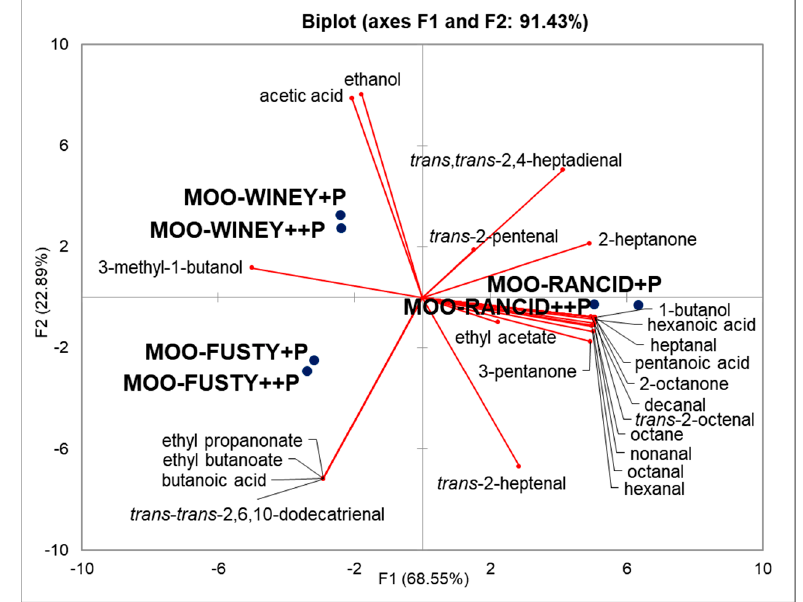
Figure 1. PCA based on SPME-GC/MS analysis of volatile compounds characterising MOO samples with the presence of sensory defects of ‘rancid’, ‘winey–vinegary’ and ‘fusty–muddy’. MOO+P code indicates the lowest level of phenolic compounds in model olive oil while MOO++P indicates the highest level.